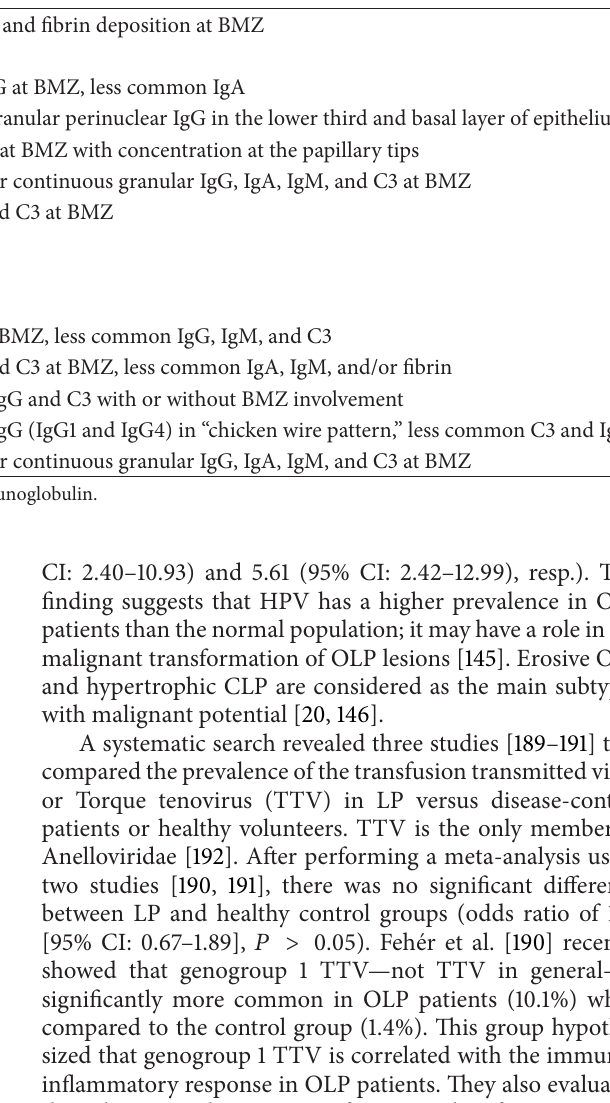
Dermatitis herpetiformis Discoid lupus erythematosus Epidermolysis bullosa acquisita Linear IgG and C3 at